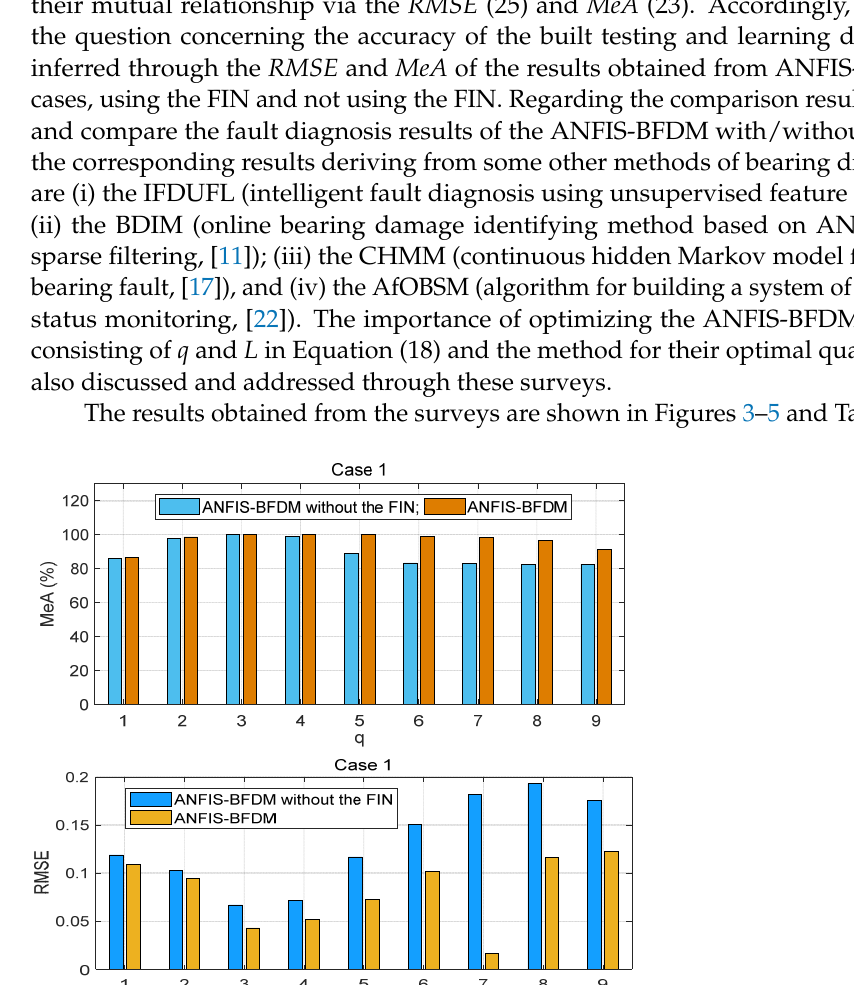
Figure 4. ”Case 2”—the positive role of the FIN expressed by the MeA and RMSE of the ANFIS ‐ BFDM via the two cases, with/without r(t) when q = 1 … 9.